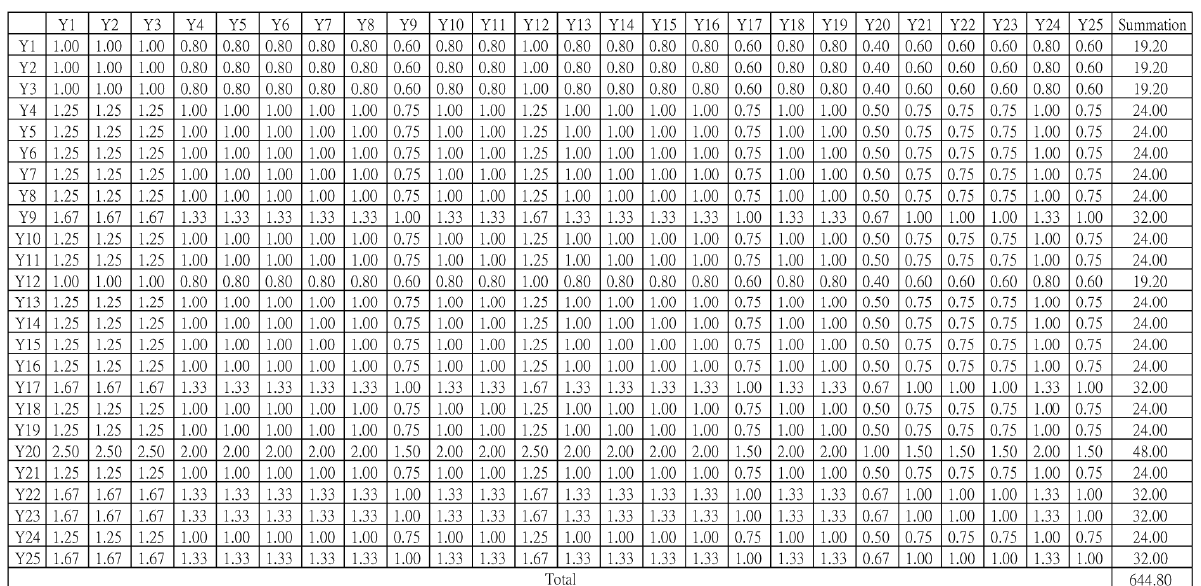
Table 2. Objective incidence matrix of the first decision-making